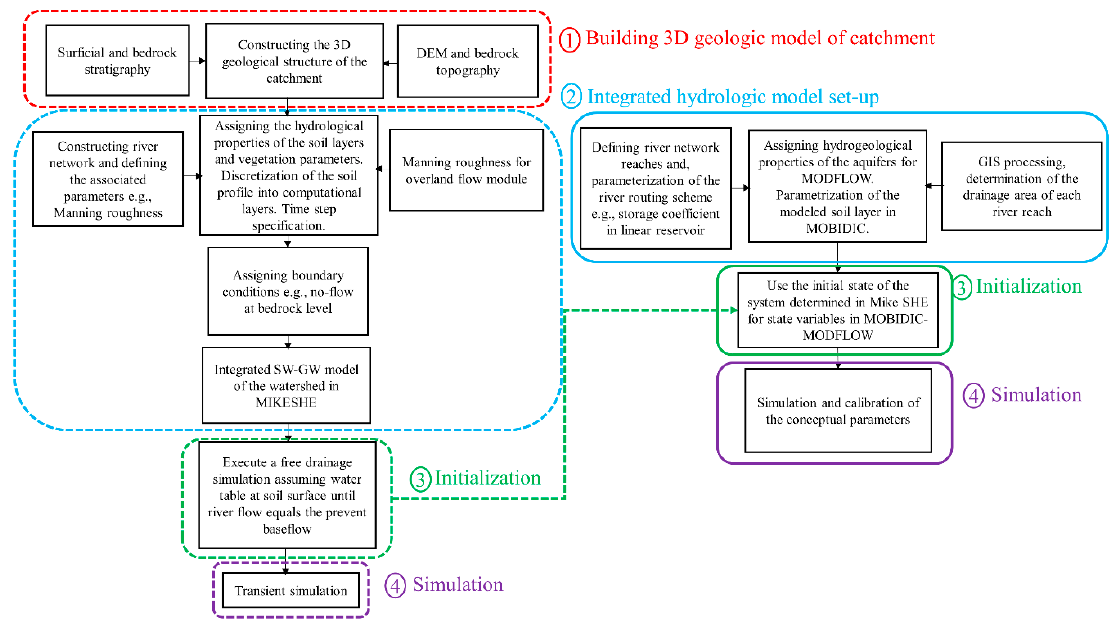
Figure 7. The step-by-step procedure of integrated surface water-groundwater modelling of the Thomas Brook catchment with MIKE SHE and MOBIDIC-MODFLOW. The left side (boxes in dash) represents the process followed in MIKE SHE and the right side (solid box) shows the corresponding steps in MOBIDIC-MODFLOW. Note that step 1 is similar in both models.